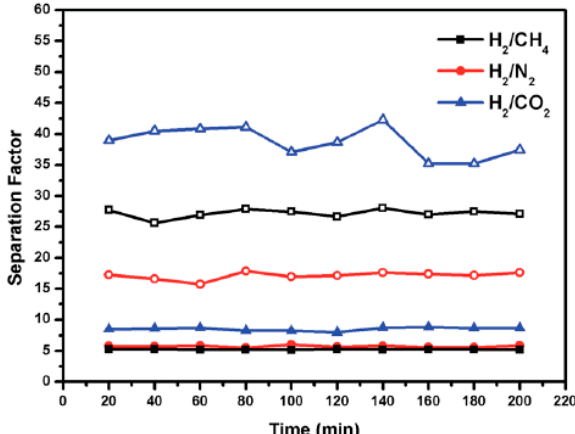
Figure 40. ( a ) The permeances of single gases through the 1 membrane at 298 K as a function of the molecular weight. ( b ) The permeances of single gases through the JUC-150 membrane at 298 K as a function of the kinetic diameters. (adapted with permission from ref. [136]).